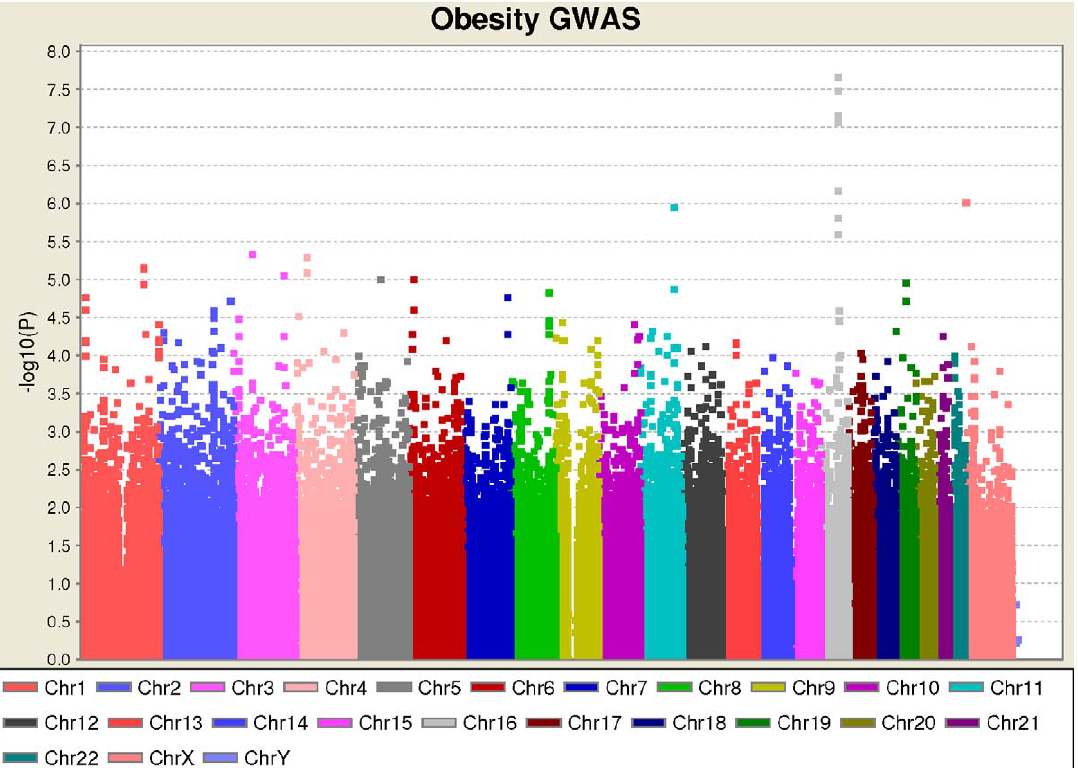
Figure 1. Manhattan plot (logarithm of P-values versus chromosome coordinates) for SNP association on obesity. The FTO locus on 16q12.2 reached genome-wide significance.